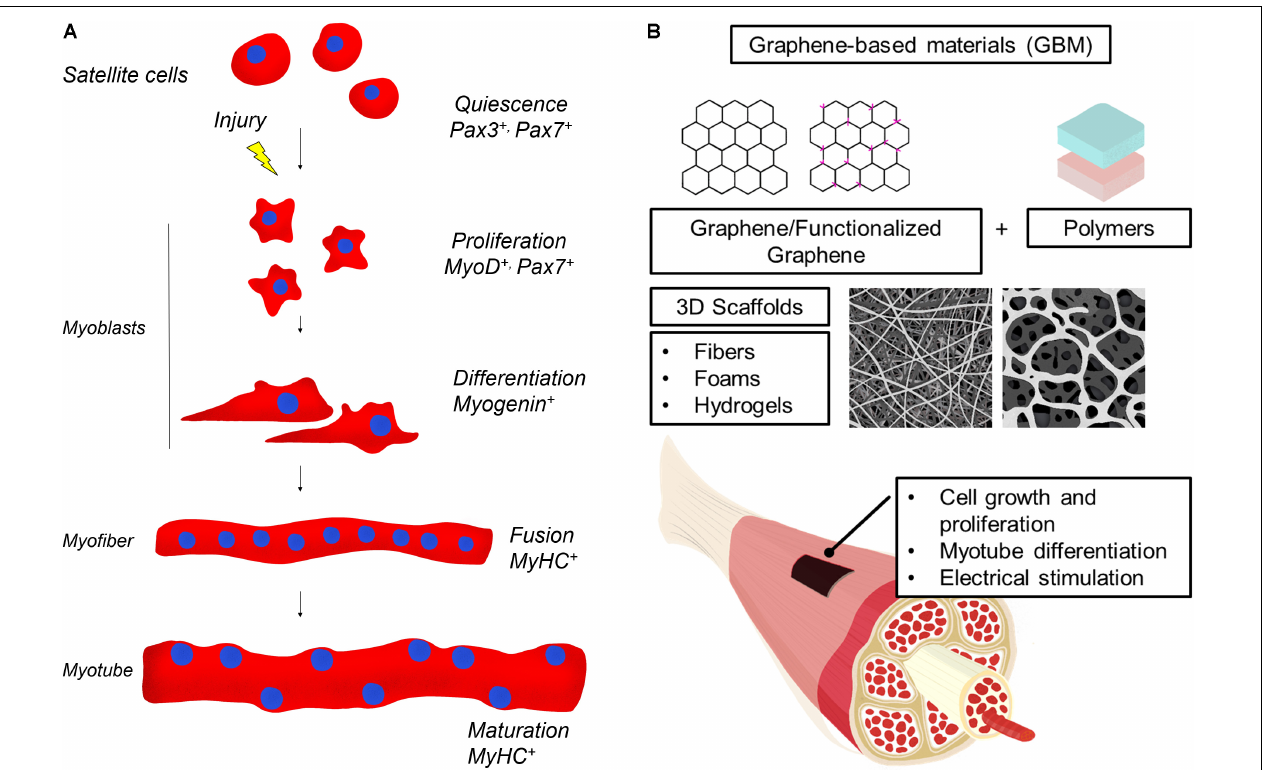
FIGURE 1 | (A) Skeletal muscle regeneration. Upon injury, quiescent muscle stem cells (satellite cells) undergo rapid proliferation, followed by differentiation into myoblasts, which fuse and mature to generate new muscle fibers. Muscle regeneration is characterized by the activation of transcription factors that are specific for each stage of the myofiber maturation process. In the figure, the most relevant modulators of myogenic lineage progression are indicated. (B) Illustration of GBM materials usage in skeletal muscle regeneration. GBM are obtained by combining graphene or graphene derivatives with natural or artificial polymers and a 3D scaffold is produced. GBM effects on muscle cells include induction of cell proliferation and differentiation. GBM are also conductive and can be electrically stimulated to favor muscle